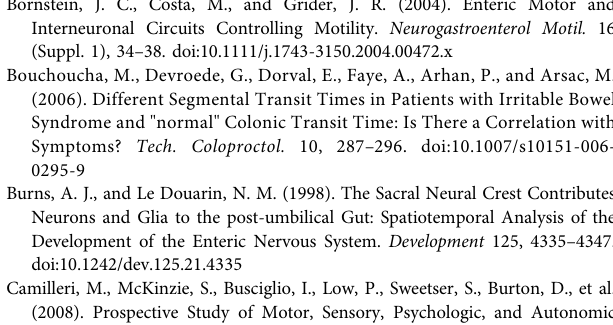
Figure 1G . (B) Length of jejunum: 32.5 ± 6.45 mm and 36.3 ± 7.03 mm for the control and ENS-ablated guts, respectively. (C) The number of OPWs per